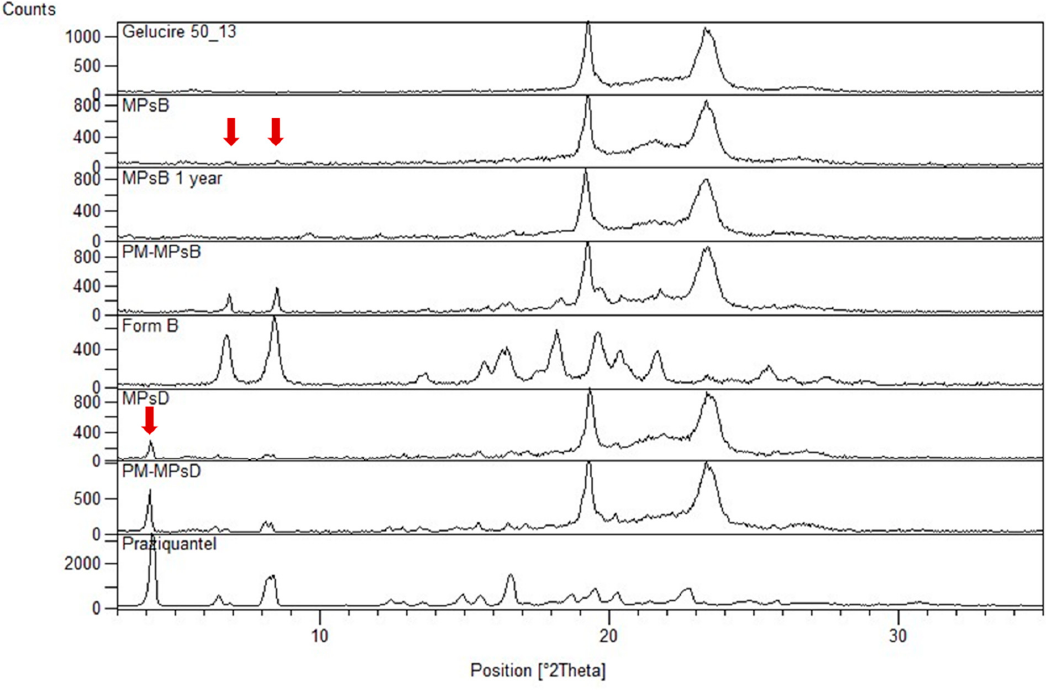
Figure 11. X-Ray Powder Diffraction Studies (PXRD) analysis of Gelucire 50/13, PZQ raw, PZQ Form B, MPs D (red arrow indicates a typical PZQ reflection), and MPs B (fresh samples and after 1 year storage) (red arrows indicate residual Form B signals) and their corresponding PM.